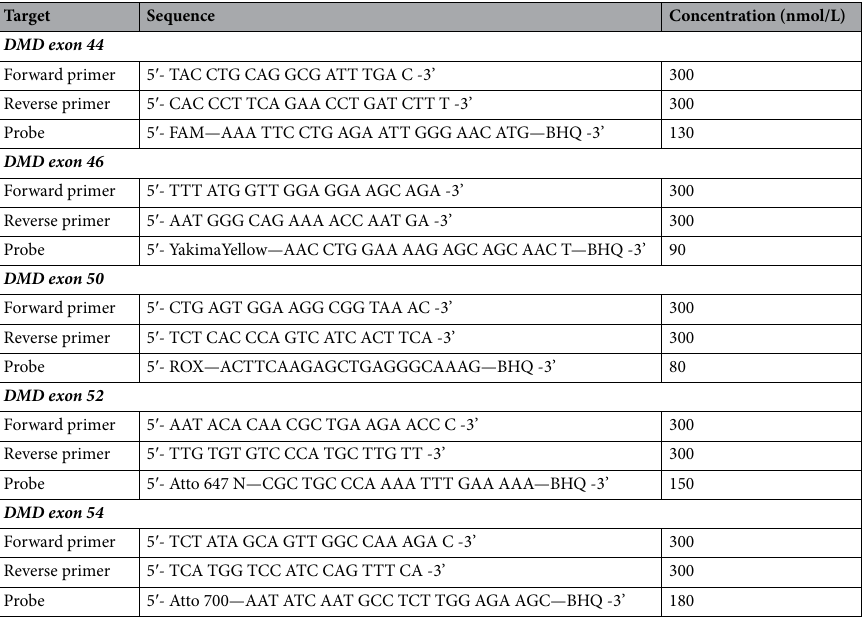
Table 3. qPCR primers and probes used to amplify and identify DMD Exons 44, 46, 50, 52 and